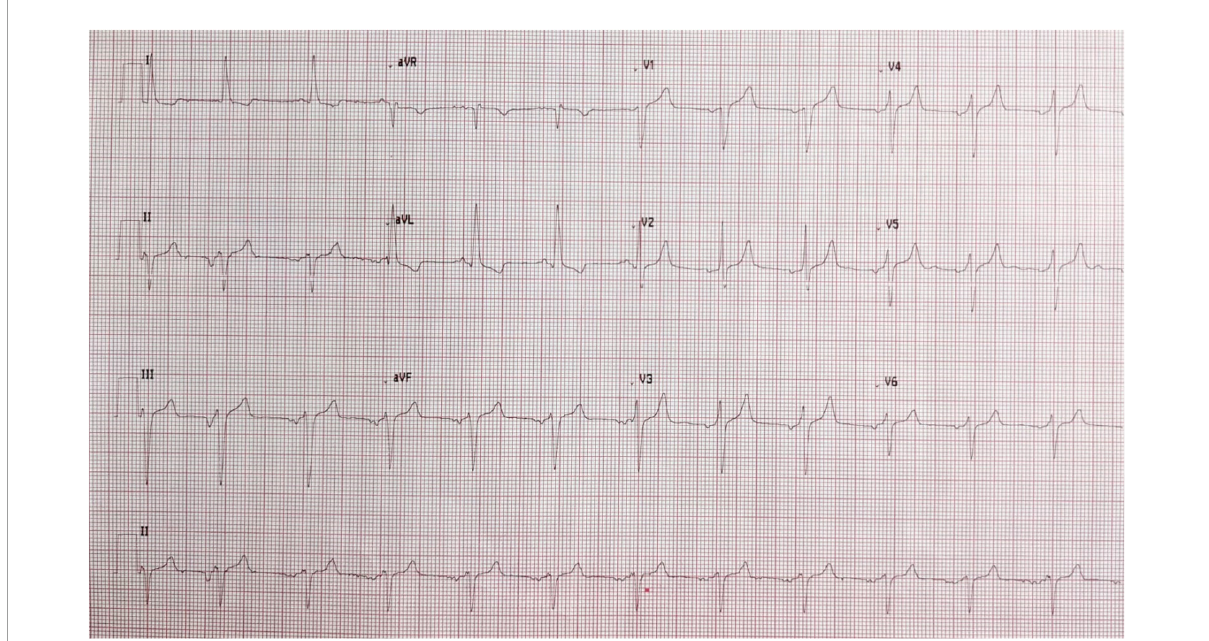
FIGURE1 Electrocardiogram: ectopic atrial rhythm, left anterior hemiblock, signs of left ventricular hypertrophy.